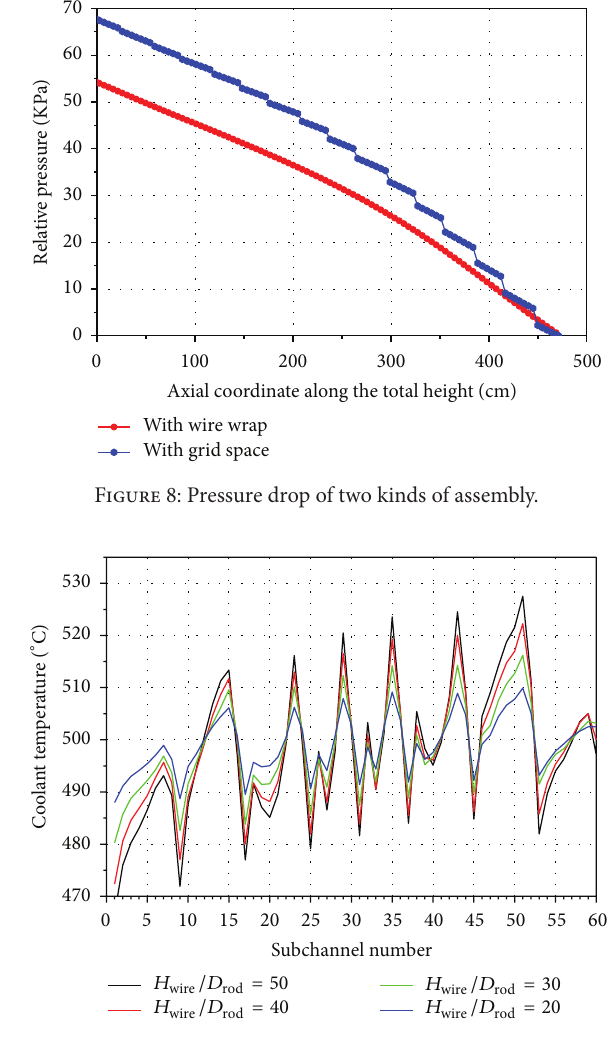
Figure 9: Exit cooling temperature profile with different 𝐻 values.